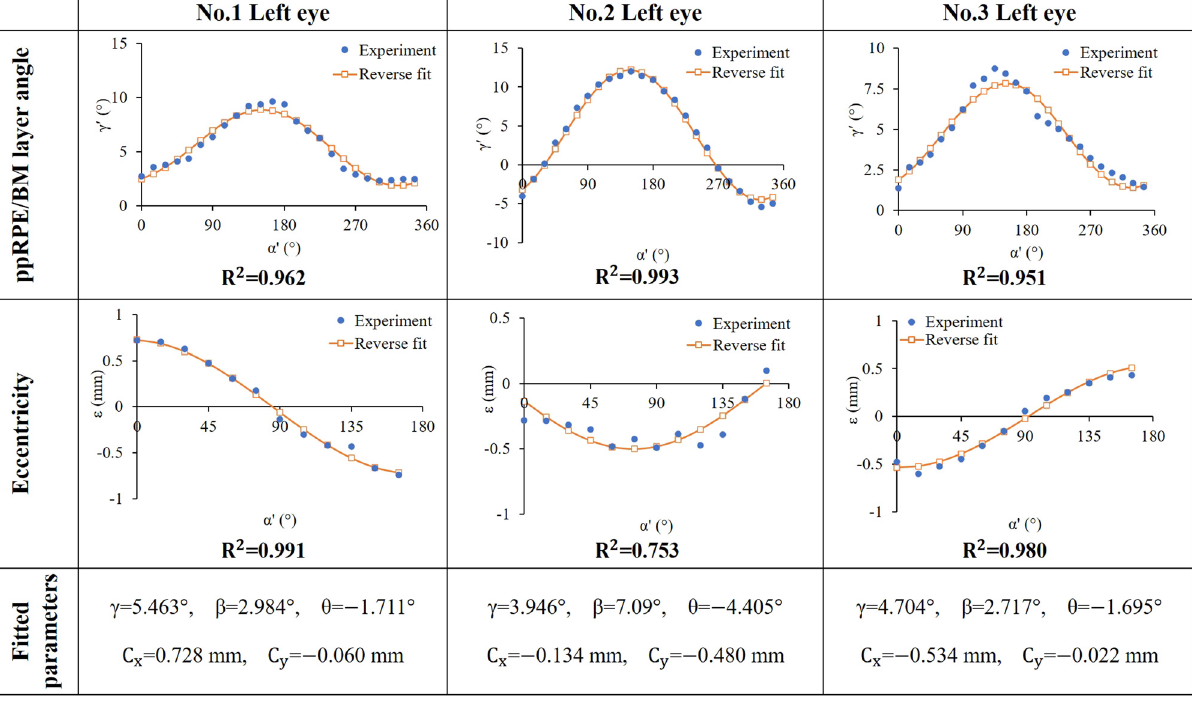
Figure 8: Comparison between the experimental measurements and model fi tting results with respect to γ ′ ( fi rst row ) and ε ( second row ) of three left eyes. The fi tted parameters were shown in the third